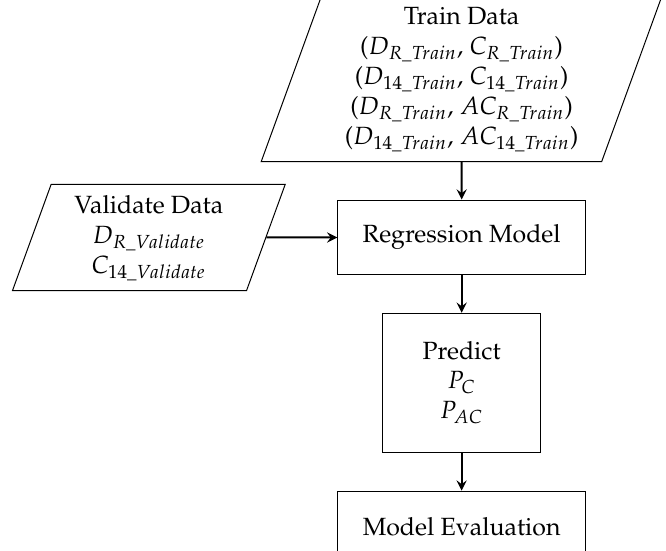
Figure 5. The process of training and verifying the regression